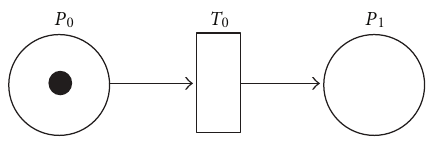
Figure 1: Example of Petri